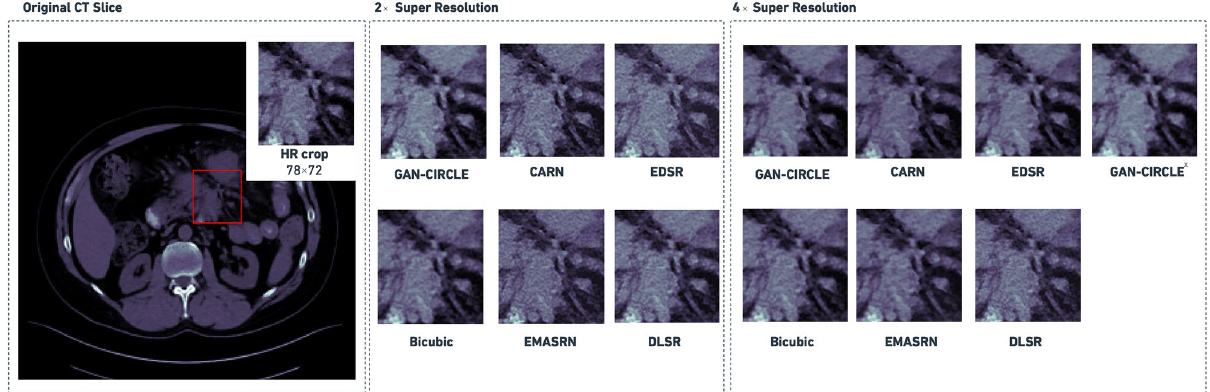
Figure 5. SR example ( 2 × and 4 × factor) using the investigated SR methods from a sample slice randomly selected from the Deeplesion dataset (held-out set). In the case of 4 × SR, GAN-CIRCLE x denotes the sequential application of two GAN-CIRCLE instances at 2 × SR.